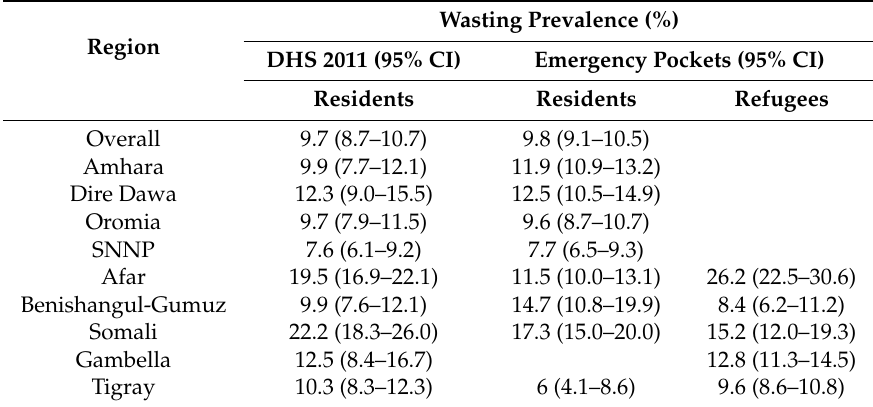
Table 5. Comparison of wasting prevalence between DHS 2011 and emergency pockets, by region and population